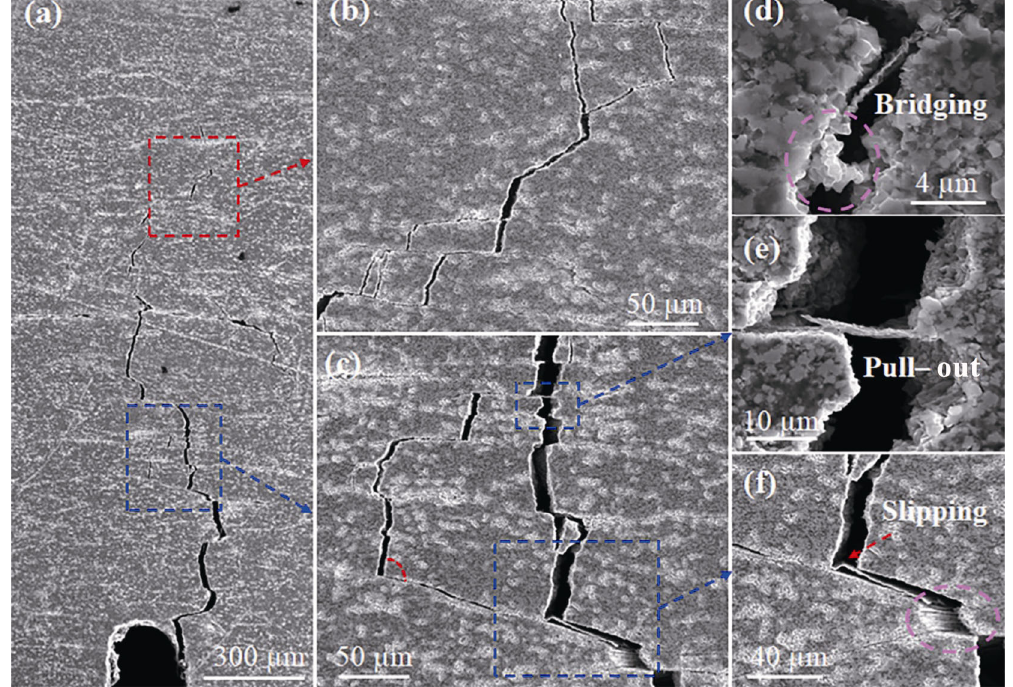
Fig. 9 Crack propagation of ZrC–SiC–graphene composites (a); crack deflection and crack branching in the partially enlarged view of the red (b) and blue (c) square dashed frames in (a); bridging (d), pull-out (e), and slipping (f) of graphene sheets. Reproduced with permission from Ref. [157], © Elsevier Ltd.